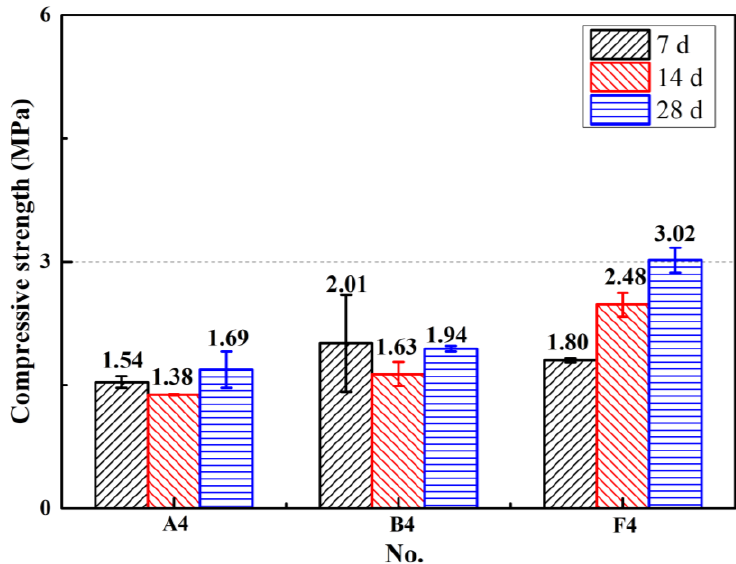
Figure 6. Compressive strength of specimens when water-to-binder ratio is 4.